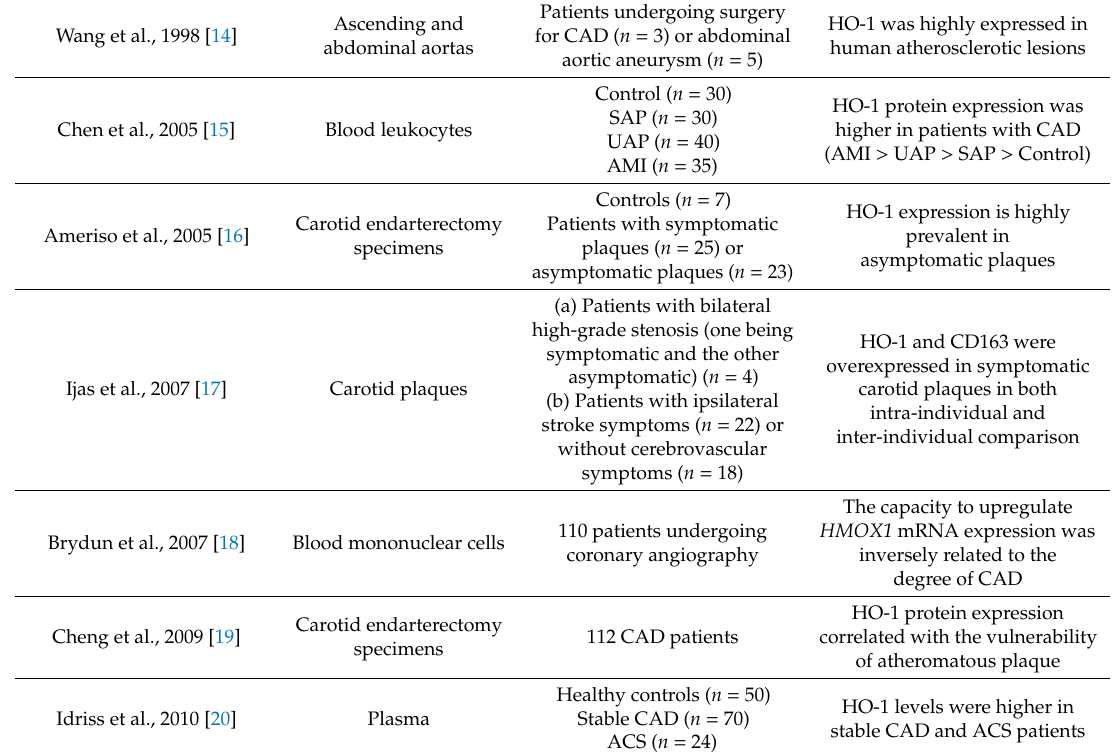
Table 1. Studies of the relationships between heme oxygenase (HO)-1 levels and atherosclerotic diseases. Ascending and Wang et al., 1998 [14] abdominal